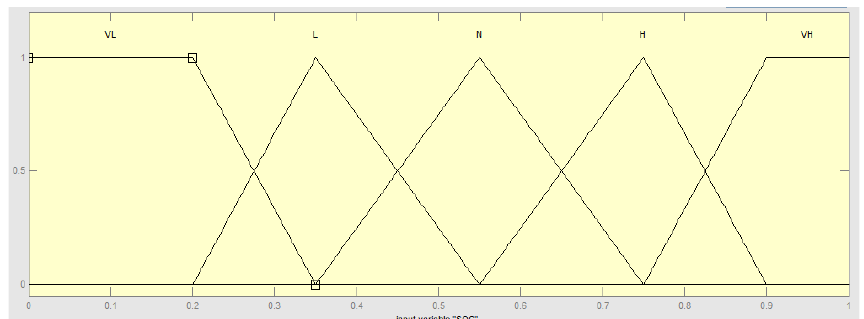
Figure 2. Demand torque membership function.